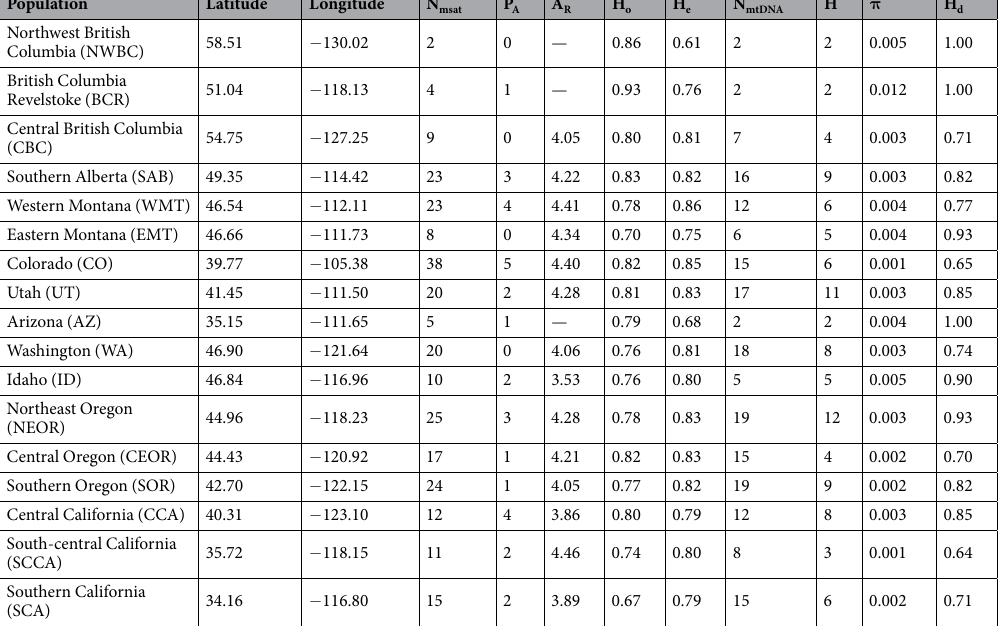
Table 1. Microsatellite and mitochondrial genetic diversity statistics within populations of mountain chickadee; latitude, longitude, number of samples screened at microsatellite loci (N msat ), private alleles ( P A ), allelic richness ( A R ), observed heterozygosity ( H o ), expected heterozygosity ( H e ), number of samples sequenced for mtDNA control region ( N